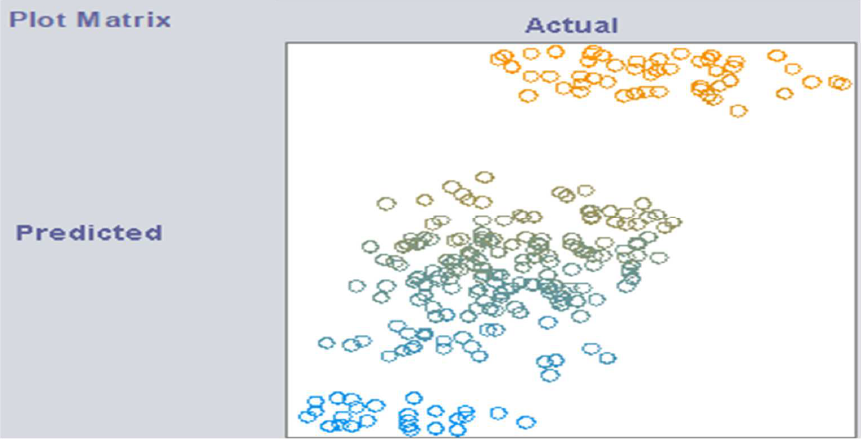
11 of 15 Figure 6. Random forest algorithm.